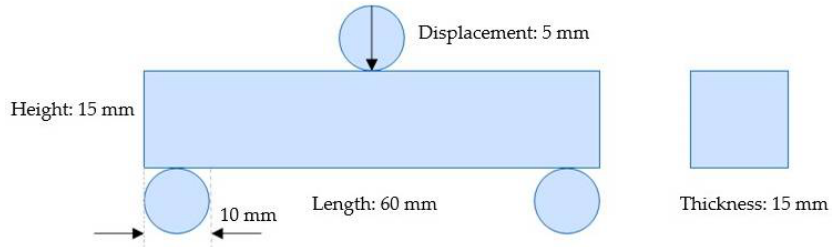
Figure 1. Geometric boundary conditions of the verification part for FEA.